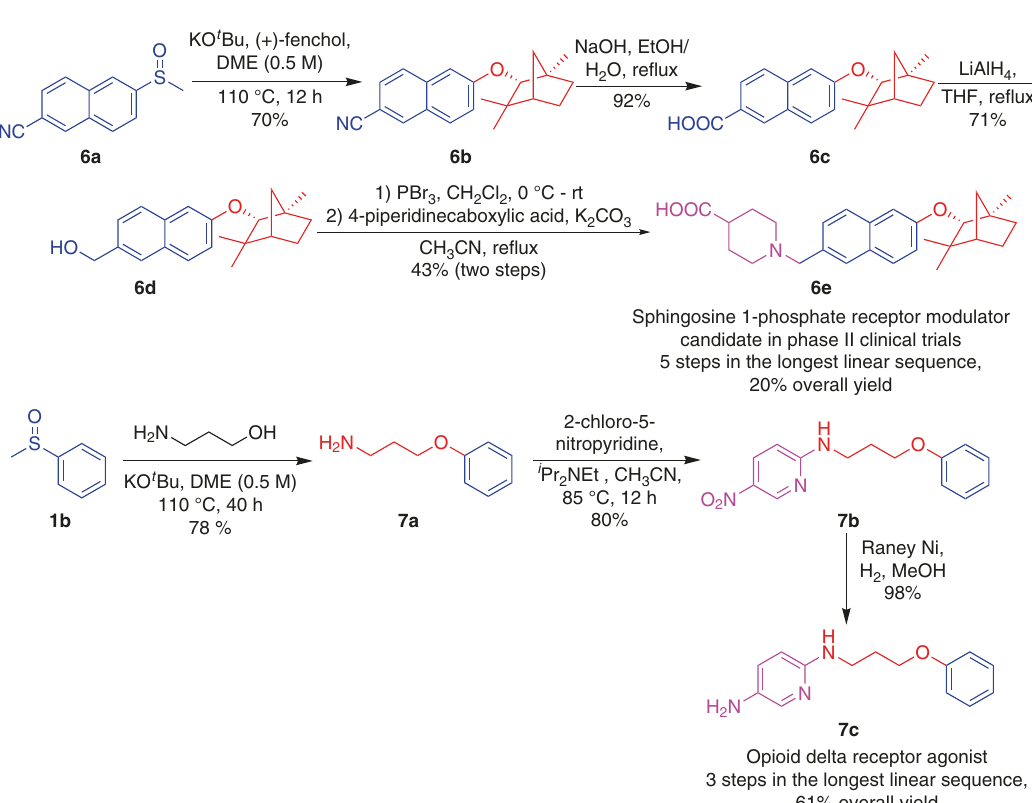
Fig. 4 Synthetic applications. Application of transition-metal-free cross-coupling of aryl methyl sulfoxides with alcohols to pharmaceuticals.